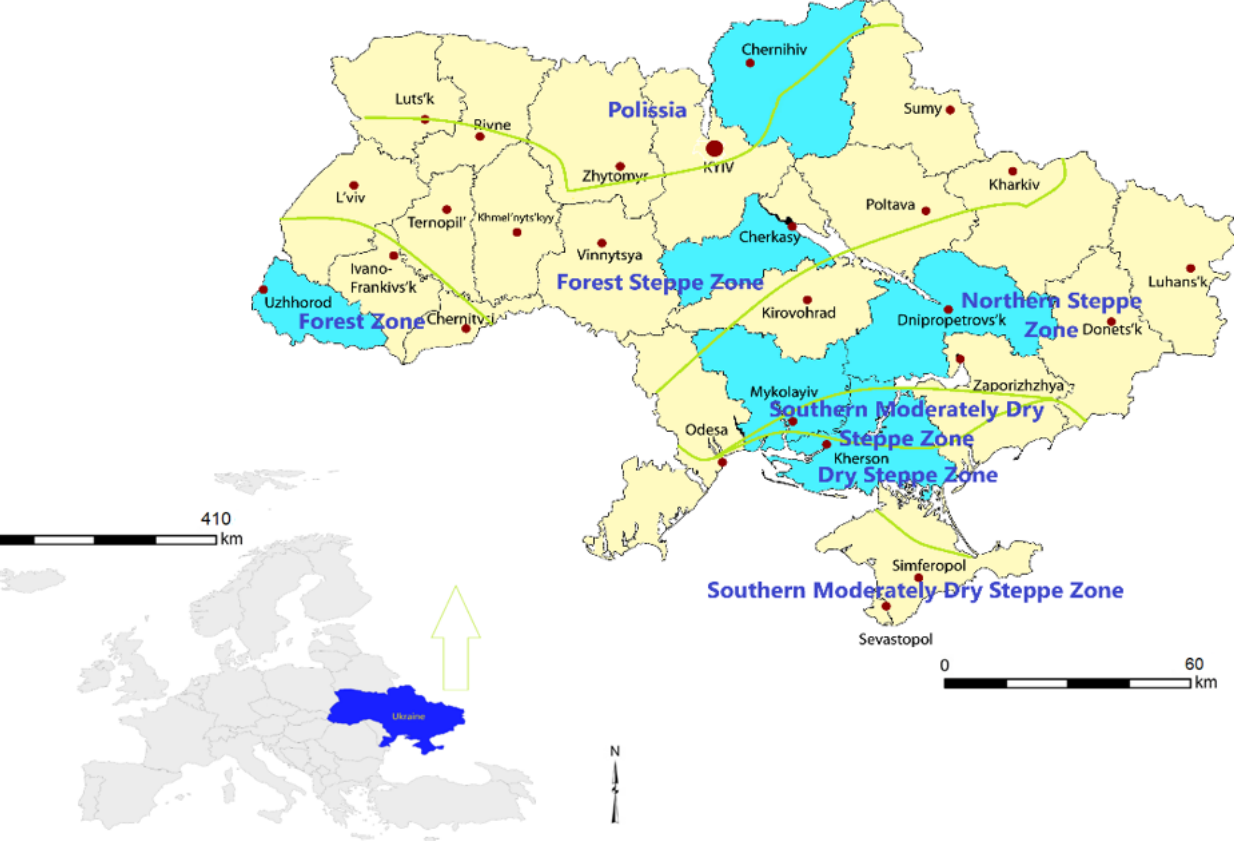
Figure 1. Location of the study regions on the map of Europe and the map of Ukraine (the studied territories are marked with turquoise color; green lines are the borders of the climate zones).